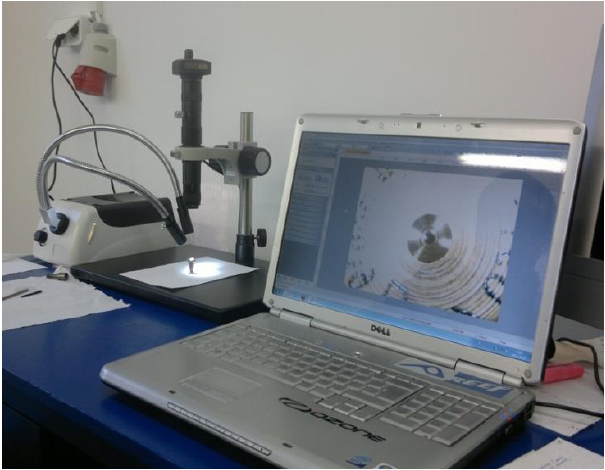
Fig. 3. Microscope Meiji FL150/70